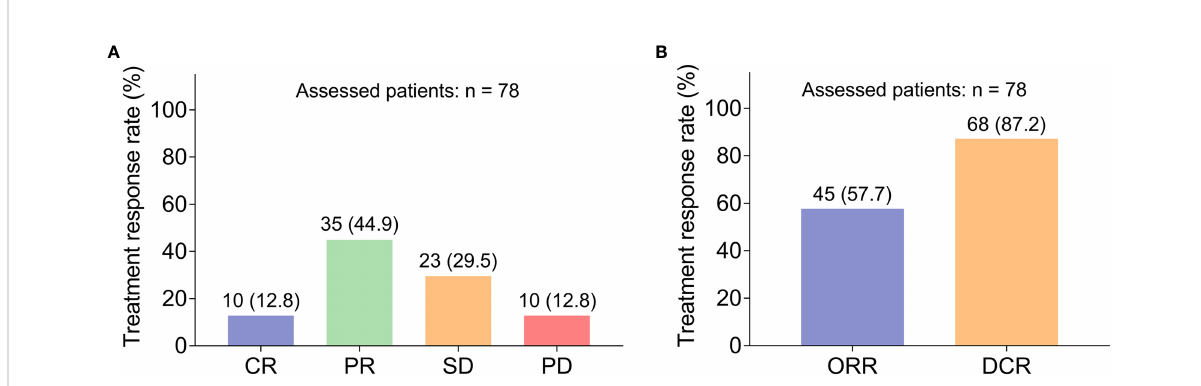
FIGURE 2 Treatment response. The CR, PR, SD, and PD rates in HCC patients receiving camrelizumab plus TACE (A) ; The ORR and DCR rates in HCC patients receiving camrelizumab plus TACE (B) . HCC, hepatocellular carcinoma; TACE, transarterial chemoembolization; CR, complete response; PR, partial response; SD, stable disease; PD, progressive disease; ORR, objective response rate; DCR, disease control rate.